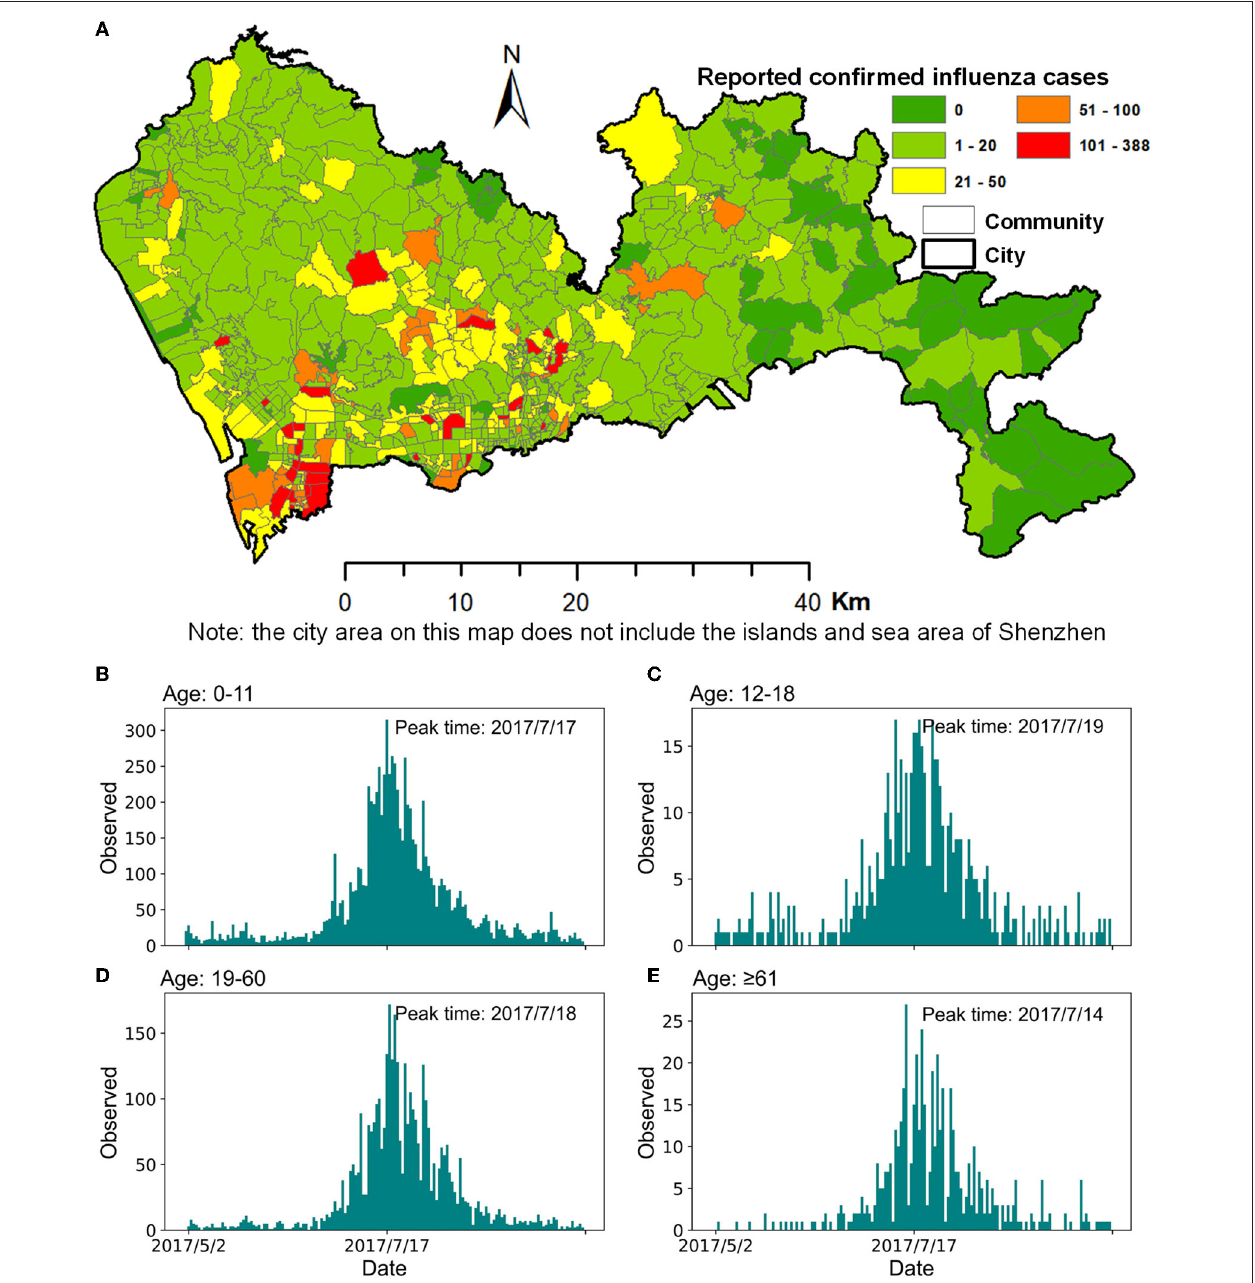
FIGURE 1 | Confirmed cases of influenza in Shenzhen during the summer season of 2017. (A) Spatial distribution of confirmed influenza cases at a community scale. (B–E) Daily reported confirmed influenza cases in different age groups.